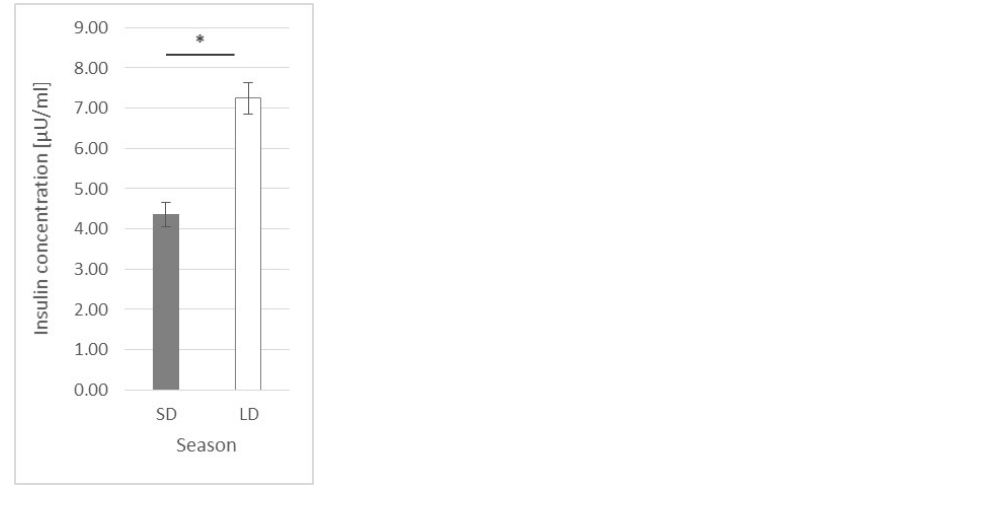
7 of 24 Figure 6. Plasma cortisol concentration—comparison among the experimental groups (control, LPS, LEP and LPS + LEP) for short-day (SD) ( A ) and long-day (LD) ( B ) photoperiods for each selected time point separately; A,B—bars with different letters differ significantly within each time point according to the two-way analysis of variance (ANOVA) followed by Fisher’s post-hoc test ( p ≤ 0.05) ( n = 6). Groups: control—saline injection, LPS—lipopolysaccharide injection at a dose of 400 ng/kg